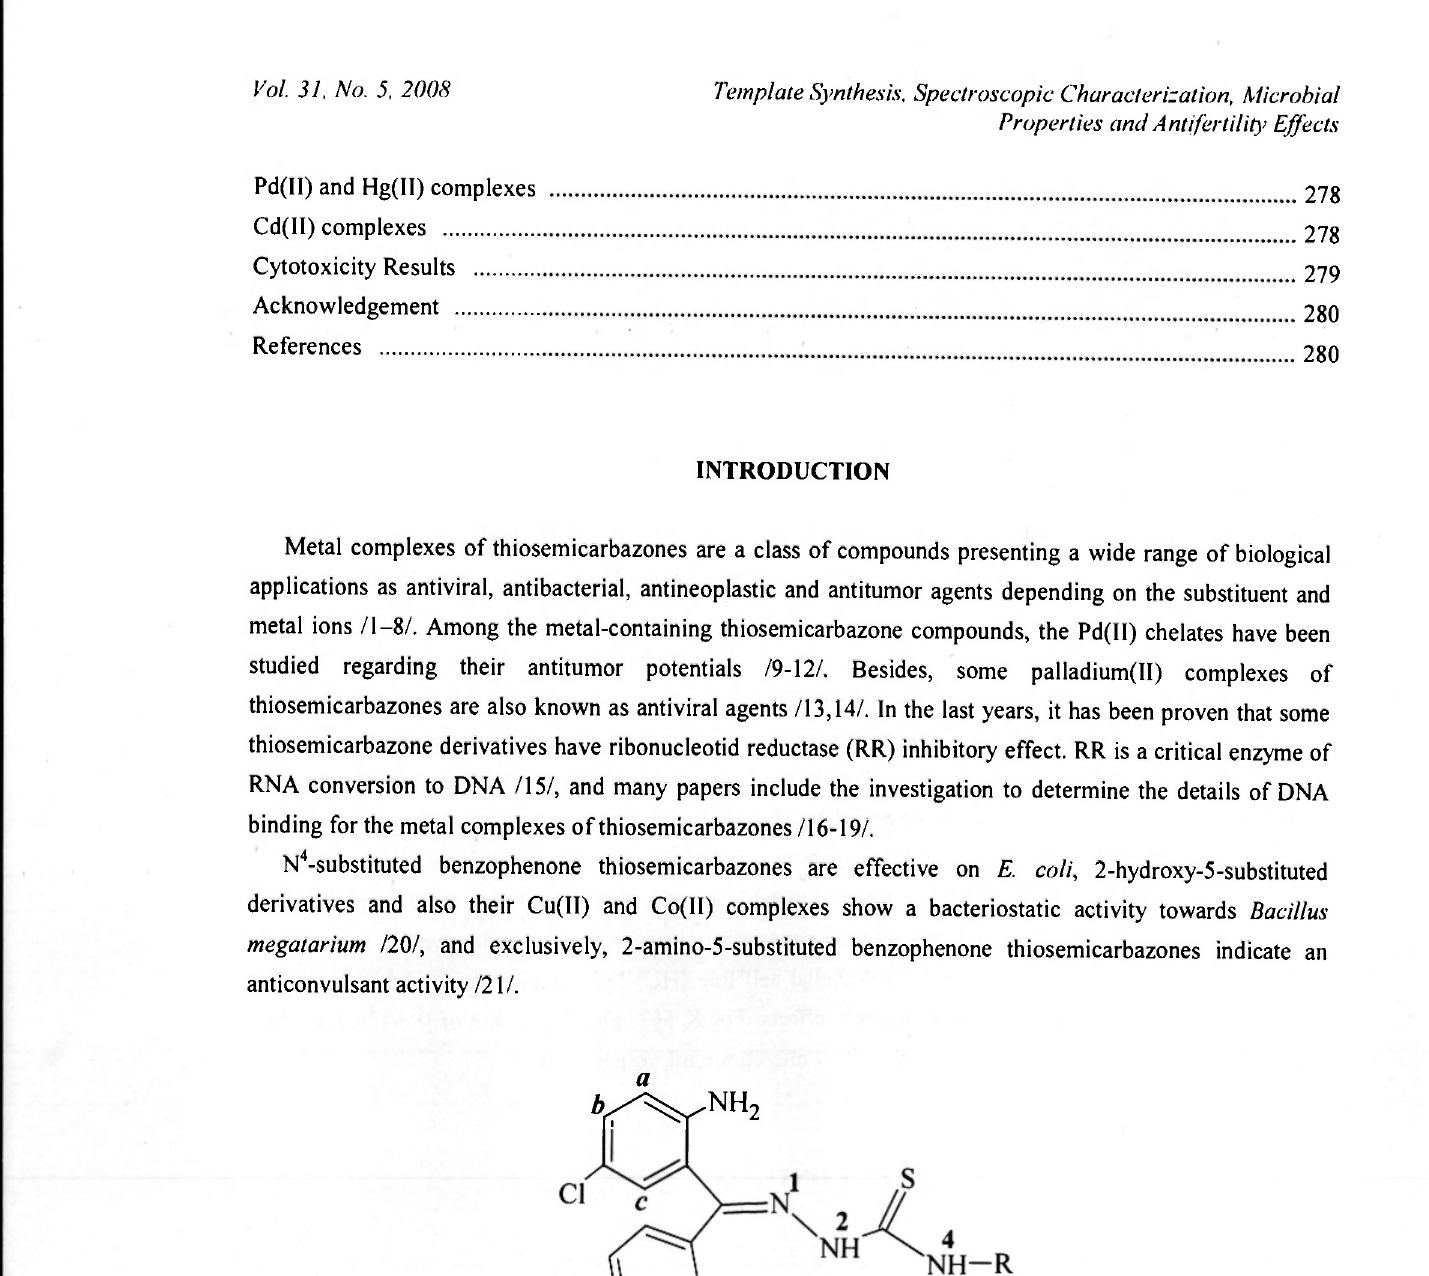
Fig. 1: 2-Amino-5-chloro-benzophenone-4-R-thiosemicarbazones, R= Η (HL 1 ); C 6 H 5 - (HL 2